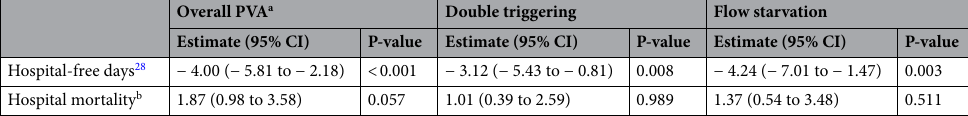
Table 5. Association between PVA and post-extubation or -weaning success outcomes (n = 599). Models are linear regression for hospital-free days and logistic regression for hospital mortality. Models account for correlation between multiple observations per subject with robust variance estimates using the generalized estimating equations approach). All models are adjusted for history of smoking, heart disease, reason for intubation, and initial ventilation delivery mode. Patients who died on ventilator (n = 97) were excluded from the analysis. a Overall PVA included flow starvation, double triggering, ineffective effort, delayed triggering and cycle mismatch. b Estimates are odds ratios and represent the increased odds of hospital mortality associated with the given asynchrony